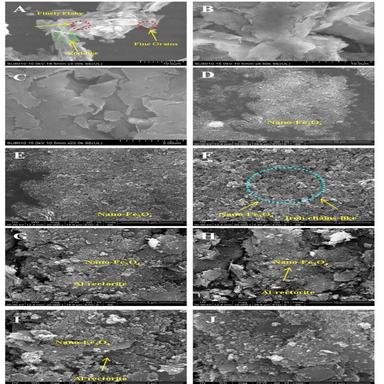
SEM photograph of samples.